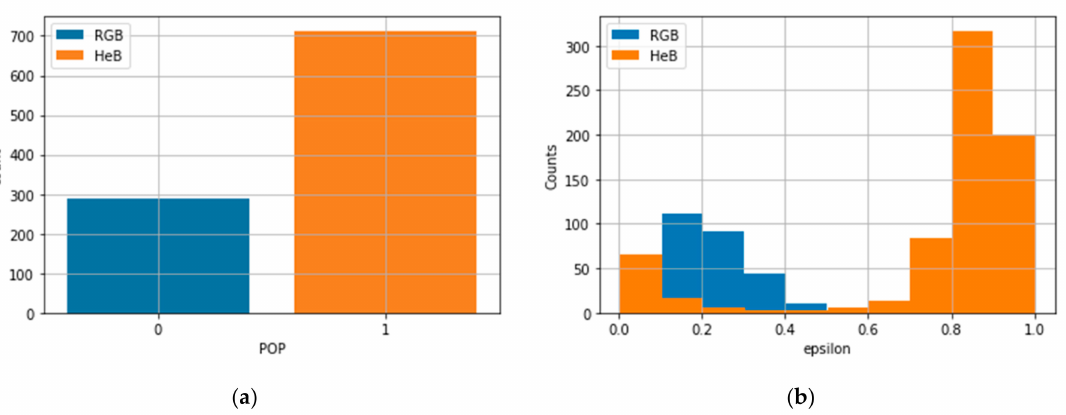
Figure 2. The asteroseismology feature analysis among the target category is listed as ( a ) the target class bar chart distribution analysis; ( b ) the Epsilon feature distribution